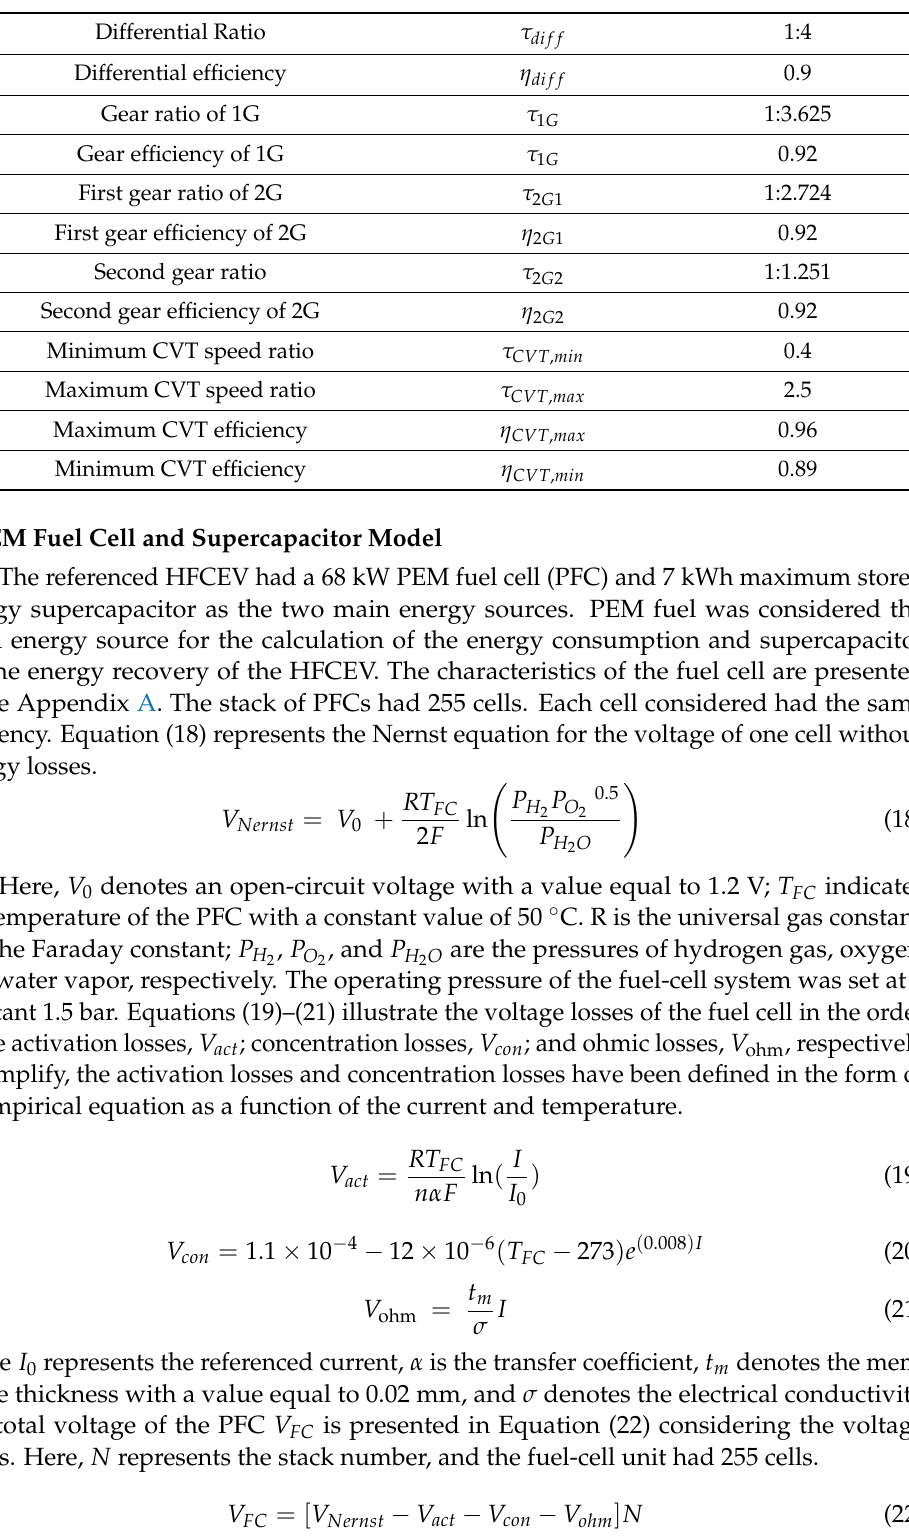
Table 2. The specifications of the powertrain